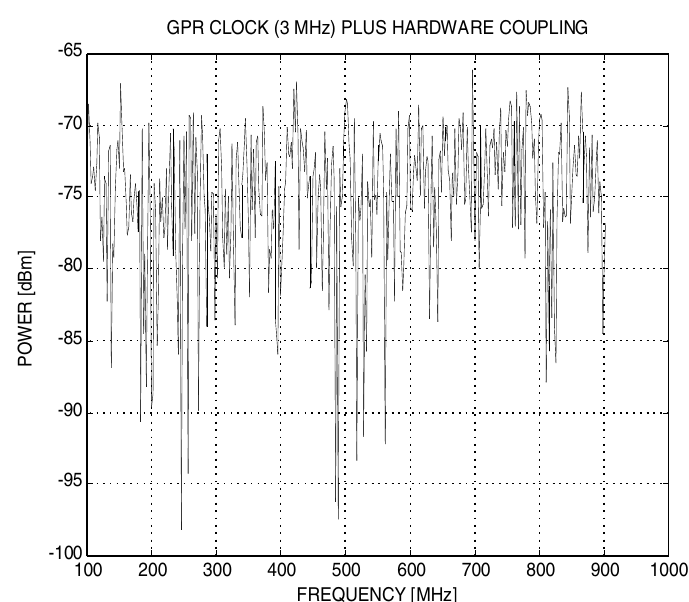
Fig. 8. Electromagnetic coupling plus timing system’s noise.